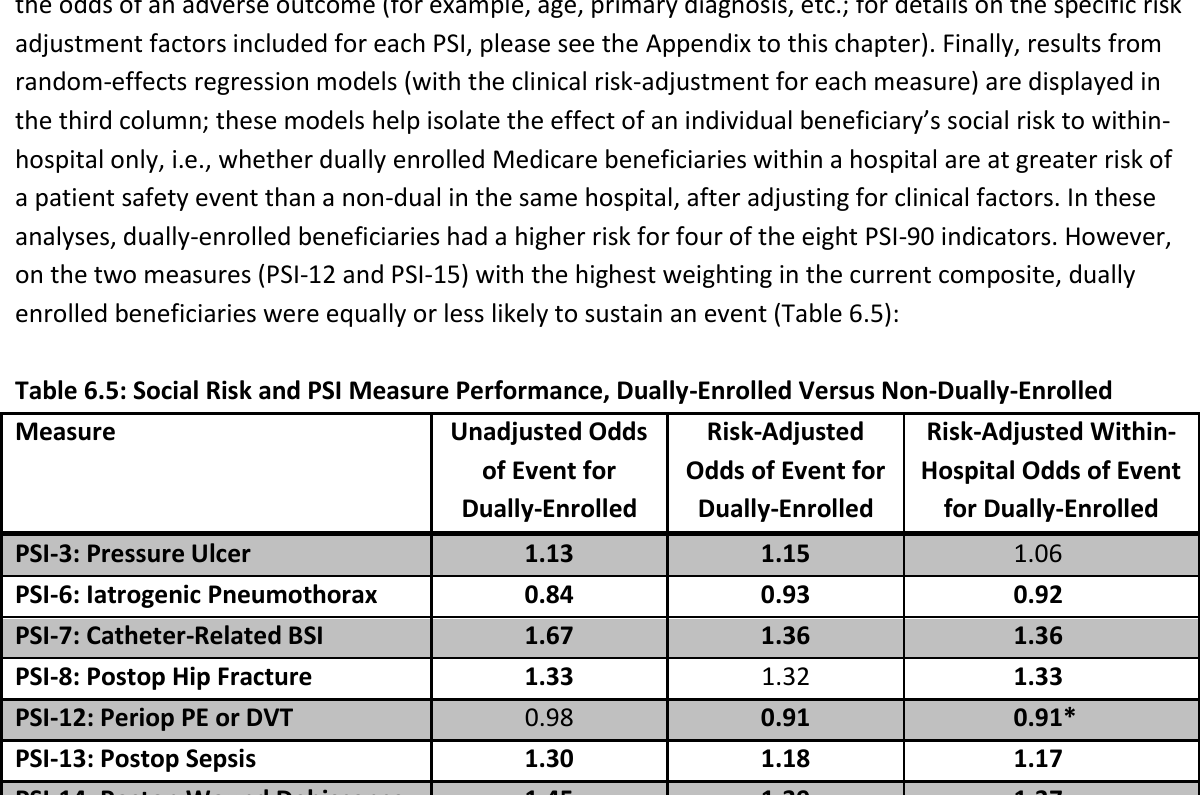
Risk-Adjusted Risk-Adjusted Within- of Event for Odds of Event for Hospital Odds of Event Dually-Enrolled Dually-Enrolled for